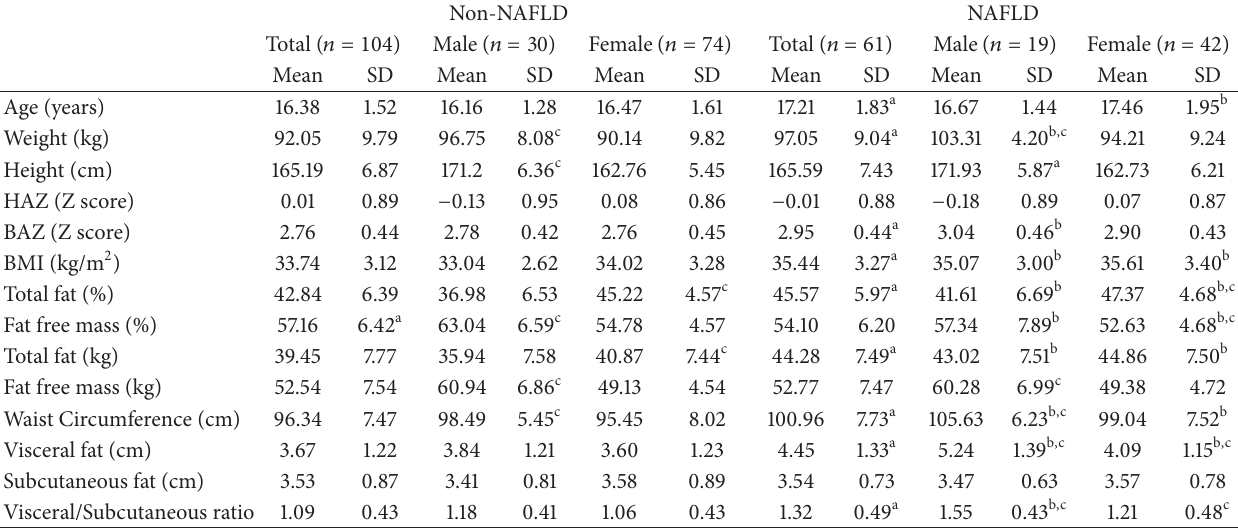
Table 1: Anthropometric and body composition characteristics of the studied population.